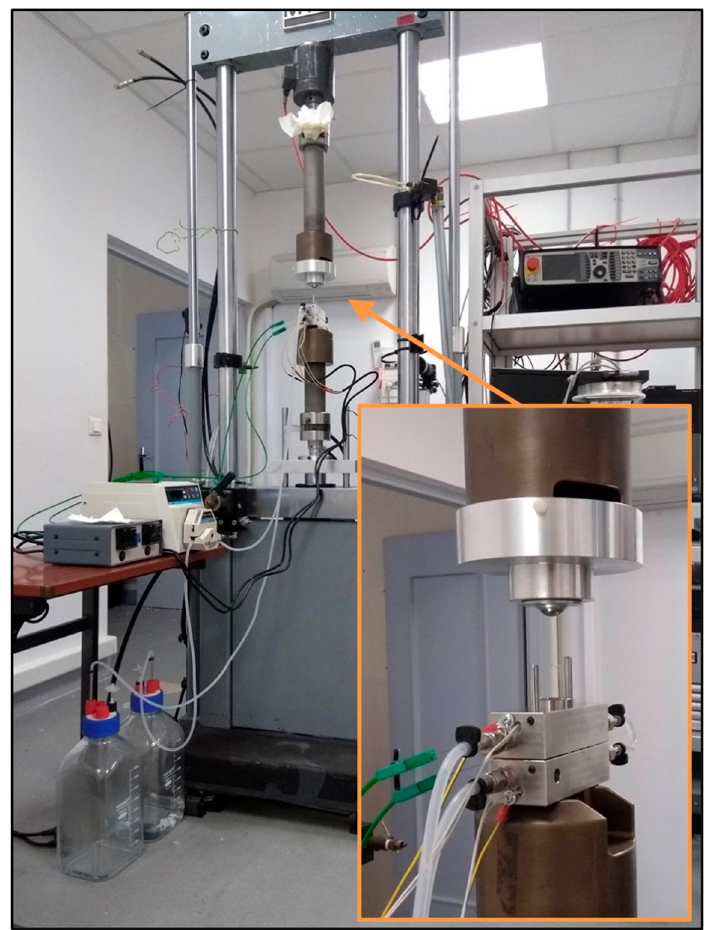
Figure 1. Photograph of the chemical-mechanical aging device. The inset focuses on the aging cell and the adapter specifically designed for this study. During the aging tests, the membrane was sandwiched between the two